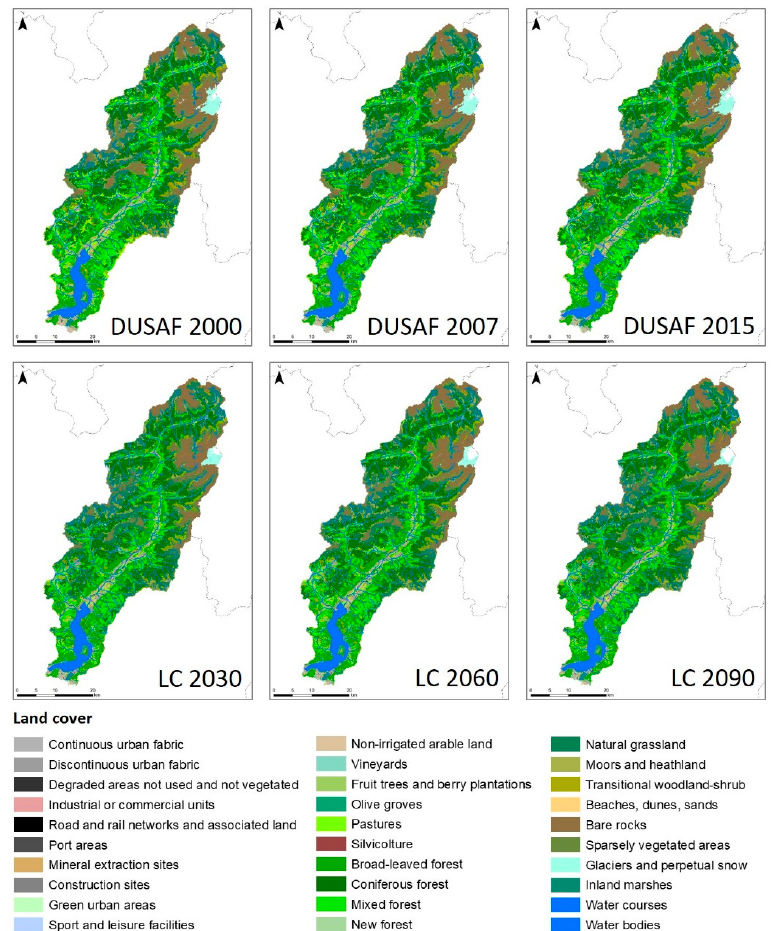
Figure 9. Past land cover (DUSAF) observed at 2000, at 2007, and at 2015 (first row); simulated land cover (LC) at 2030, at 2060, and at 2090 (second